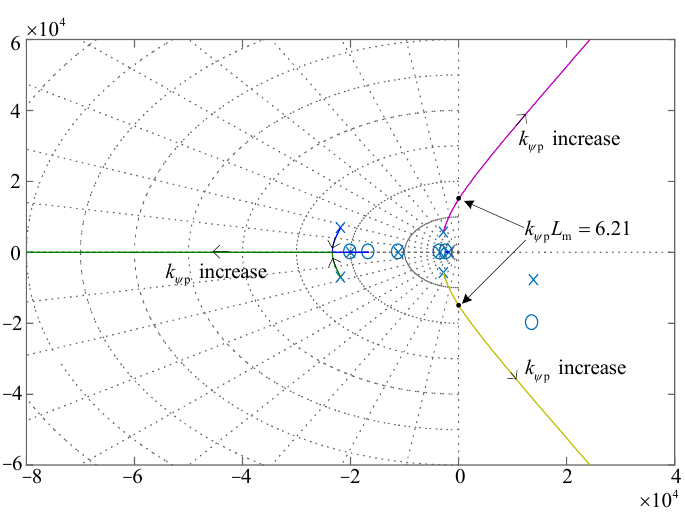
Figure 12. Root locus plot of rotor flux loop.